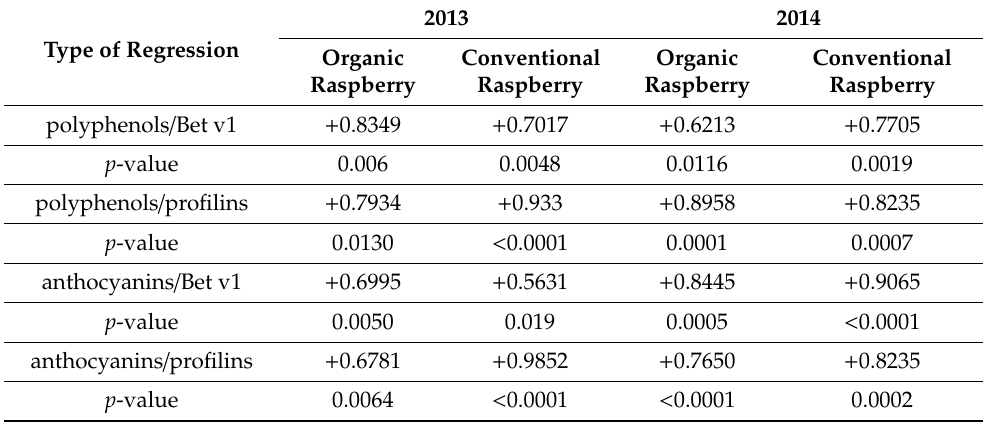
Table 6. The value of R 2 coe ffi cient for Pearson regression between phenolics compounds and allergen analogs for organic and conventional